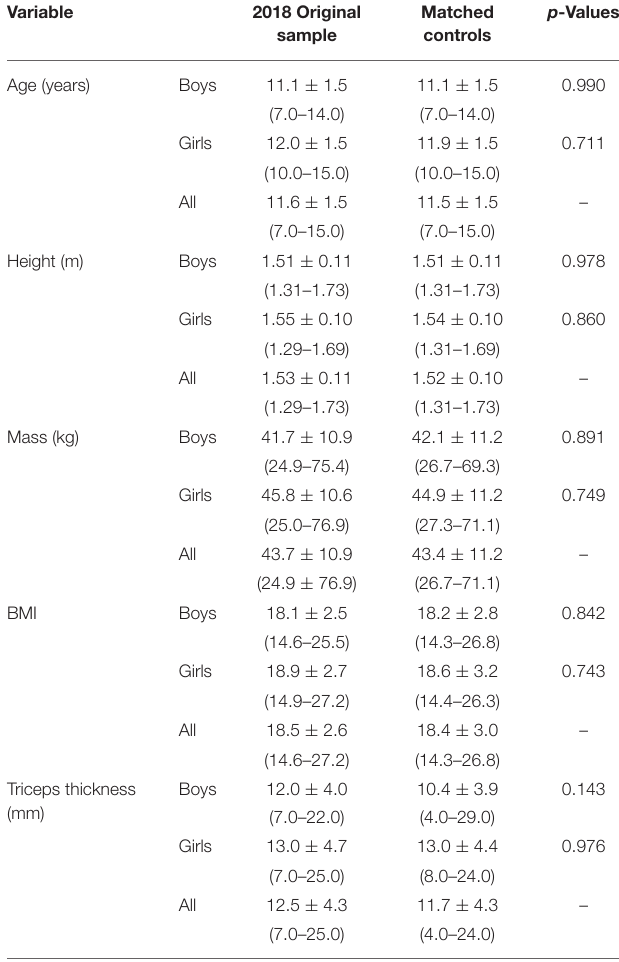
TABLE 1 | Physical characteristics of the children initially recruited to participate in the study, and the matched controls extracted for Phase 2, physical fitness assessment. Figure 3B ).